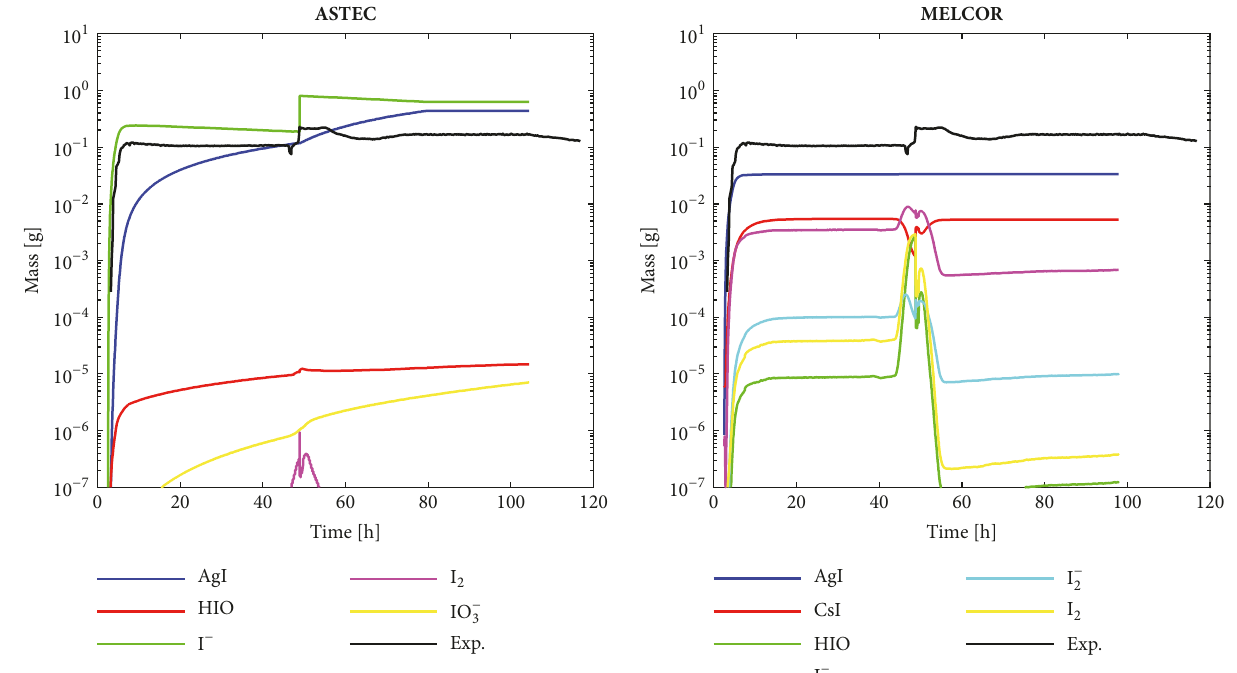
Figure 15: Iodine speciation in the sump water during the Ph´ebus FPT-2